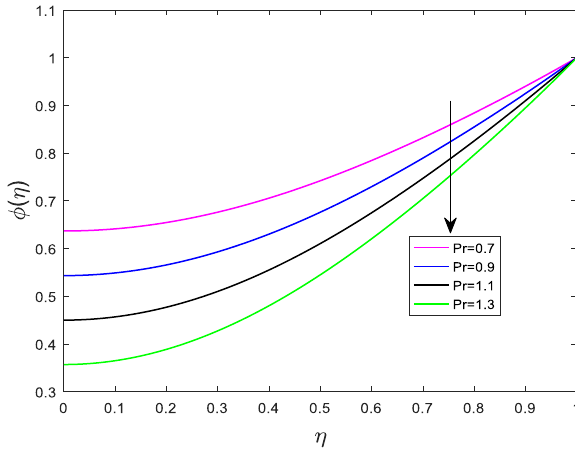
Figure 23: Effect of Ec on ϕ ( η ) for fixed S = Ω C = N t = Ec = Kr = 0.1, Ha = 0.2, N